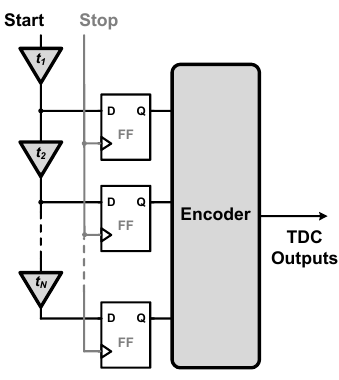
Figure 1. Architecture of the traditional TDL-TDC.